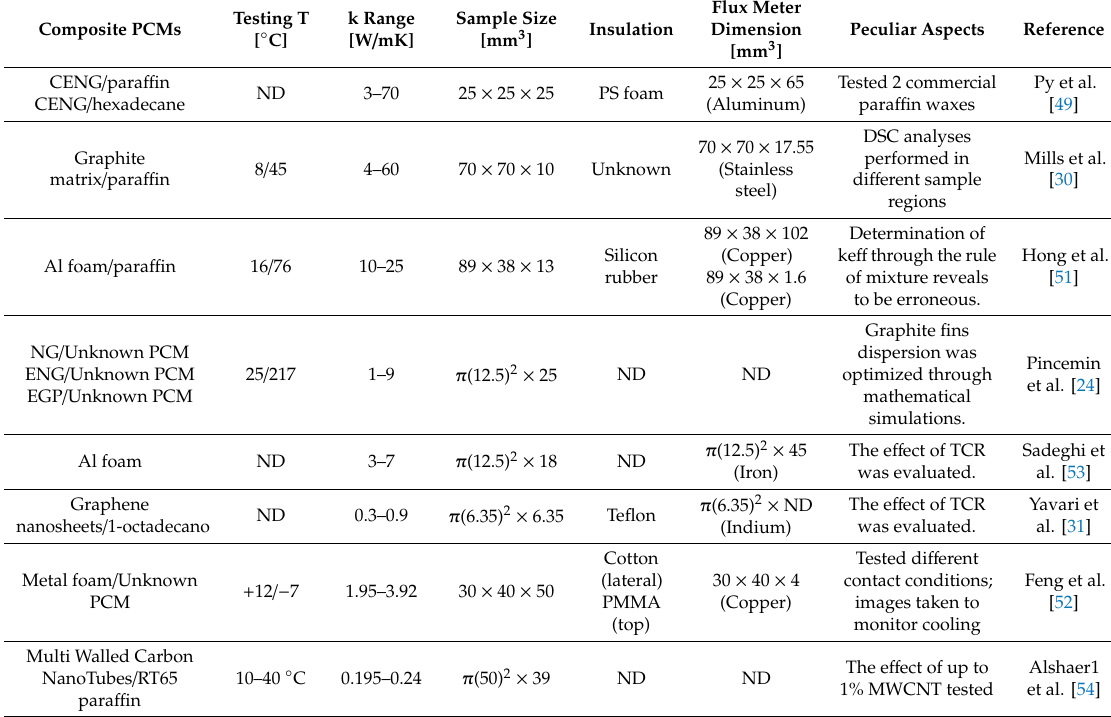
Table 1. Phases, experimental parameters and literature sources for axial flow methods on composite phase change materials (C-PCMs). In the table ND stands for ‘not defined’. TCR: Thermal Contact